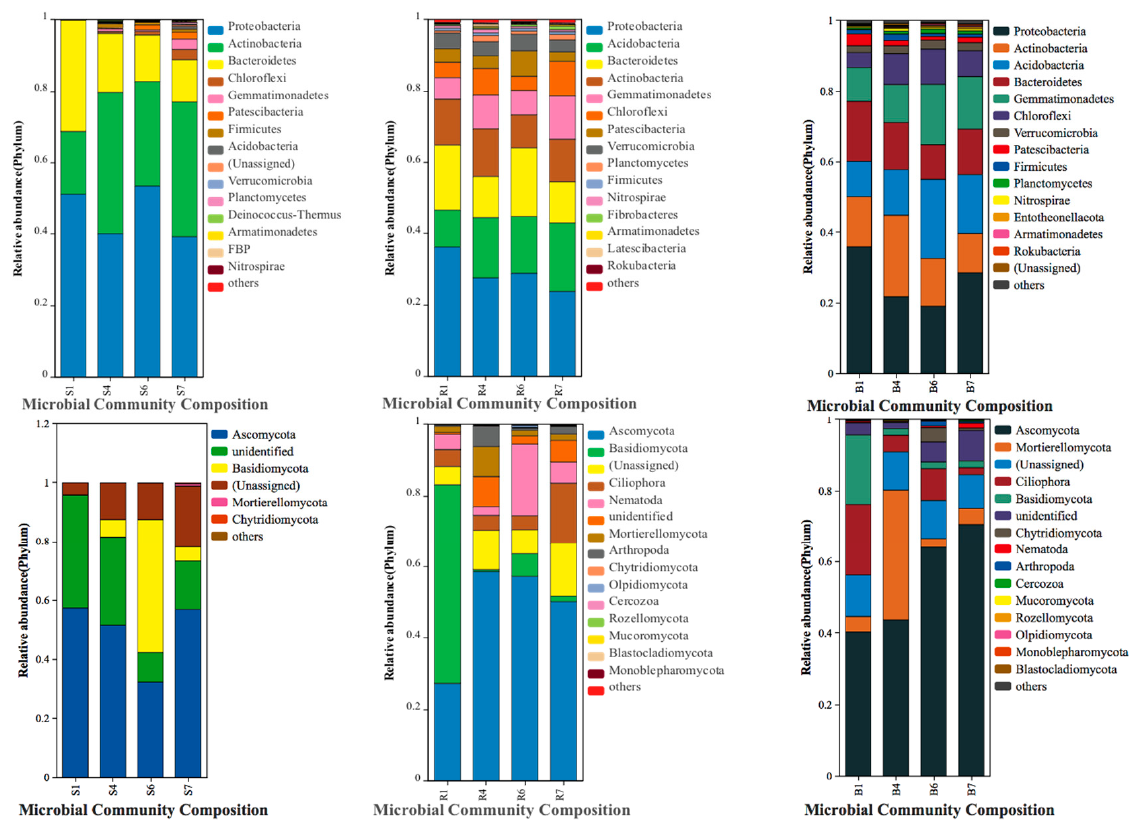
Figure 1. The abundance of the predominant bacteria and fungi at the phylum level ( ≥ 1%) of different compartments (S, R, and B indicate root endosphere, rhizosphere, and bulk soil, respectively) across the different varieties (1,6 indicate the rot-conducive variety; 4,7 indicate the rot-suppressive variety) and farming modes (1,4 belong to monoculture mode; 6,7 belong to rotation mode).